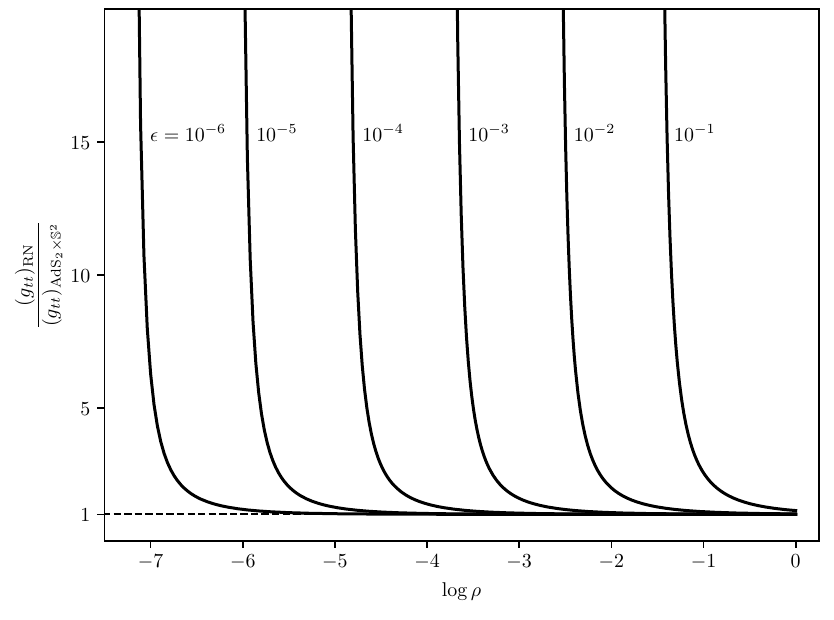
Figure 1 . A plot of the ratio of the Reissner-Nordstr(cid:127)om red-shift factor to the one of AdS 2 (cid:2) S 2 , for various values of the extremality parameter (cid:15) = m depicted). As extremality is approached, the horizon recedes to in(cid:12)nity and the geometry develops an approximate AdS (cid:2) S throat, marked by ( g tt ) RN (cid:25) ( g tt ) grows asymptotically linearly in (cid:0) log (cid:15)